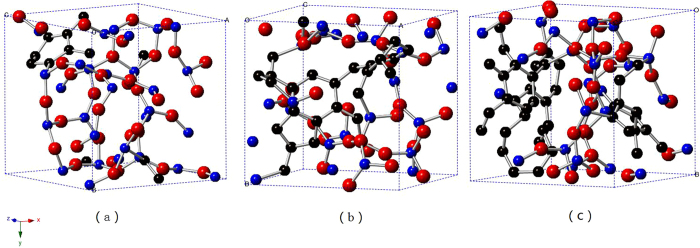
Generated amorphous SiCO structures.(a) SiC2/5O6/5, (b) SiCO6/5, (c) SiC8/5O6/5. (The Si, C and O atoms were presented as blue, black and red colors respectively).